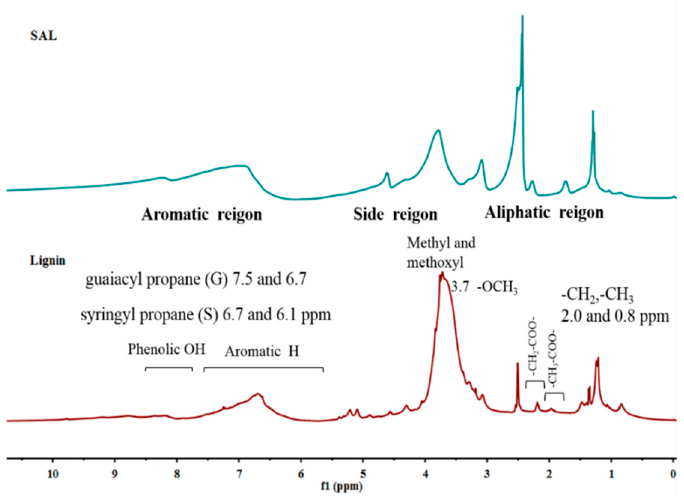
Figure 2. 1 H NMR spectra of lignin and SAL.